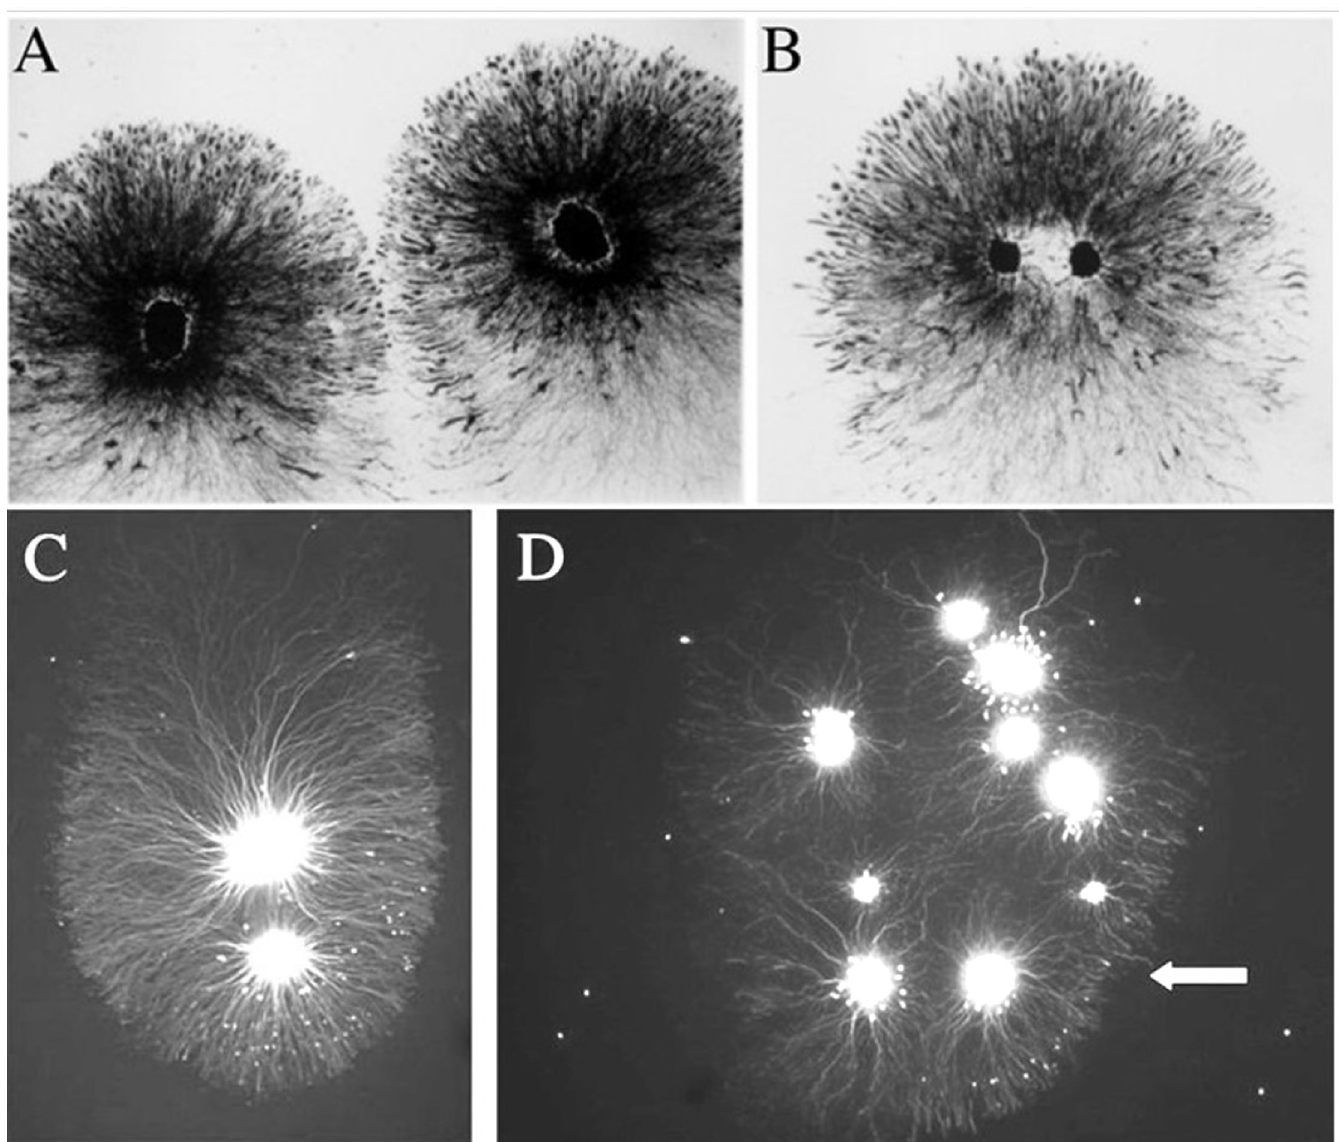
Fig 5. Explants with shared halos. Two explants growing close to each other have extended asymmetric halos, each of which shows similar orientation [A]. Two explants may contribute to a common halo that shows asymmetry with the cores situated side-by-side [B] or in “tandem” [C]. A collection of nine explants has extended halos that collectively exhibit a front of organized neurites [arrow] on one side that are shorter than those on the opposite side of the collective halo